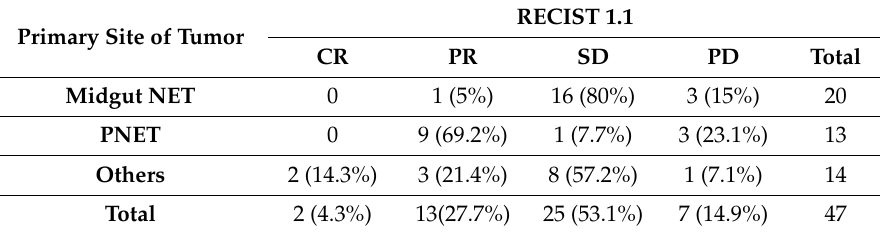
Table 4. Response rate based on primary site of